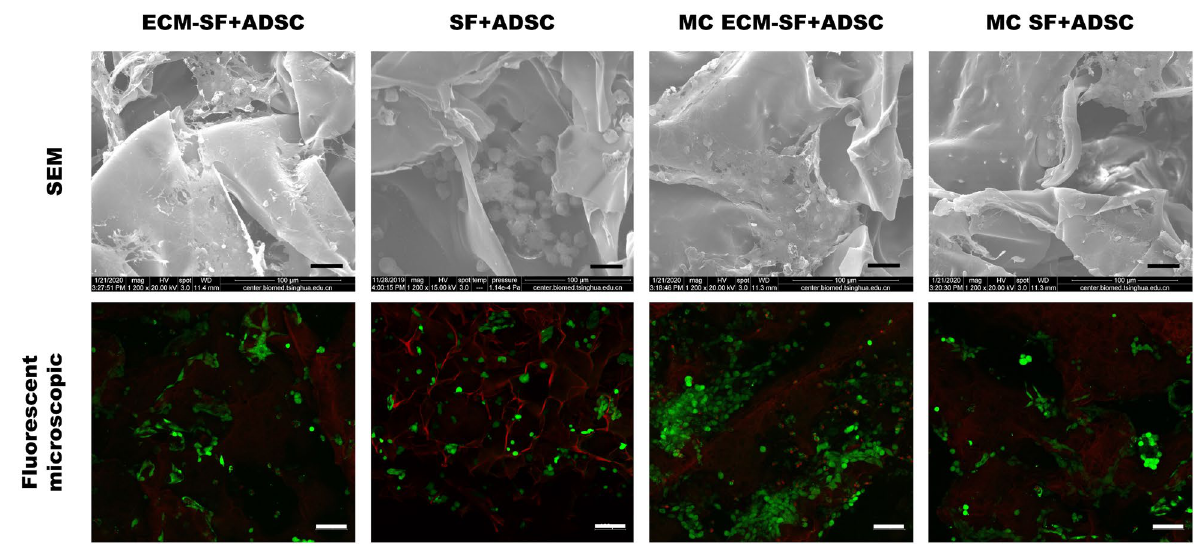
Figure 4. The cytocompatibility of the hydrogel scaffolds in vitro. SEM, bar = 30 µ m. Fluorescence microscopy, bar = 100 µ m.